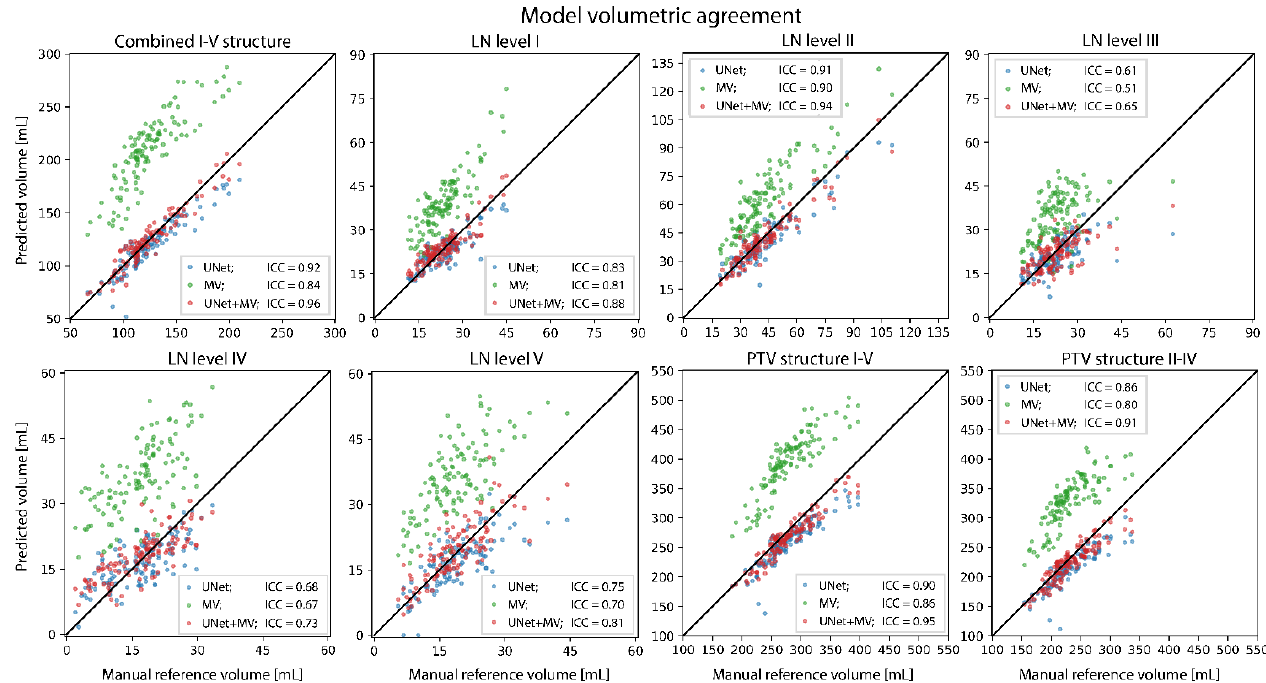
Figure 4. Predicted and manual reference volumes for all structures. Abbreviations: ICC: intra-class correlation (two-way mixed, single measures, consistency).